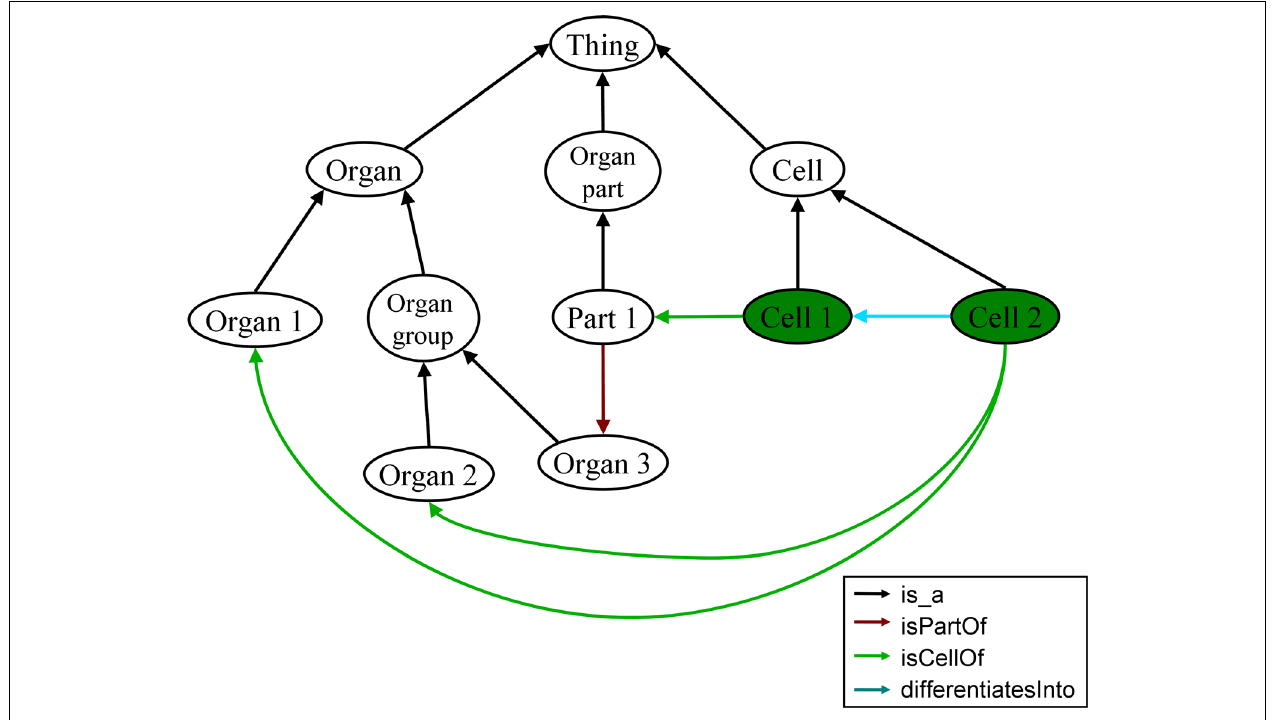
FIGURE 3 |Abstracted and simplified view of the Cytomer ontology illustrating the handling of organs of an anatomical entity. The green nodes are the start nodes for the search function specified in the text. In this section, the entities are connected by four different relations given in the legend.